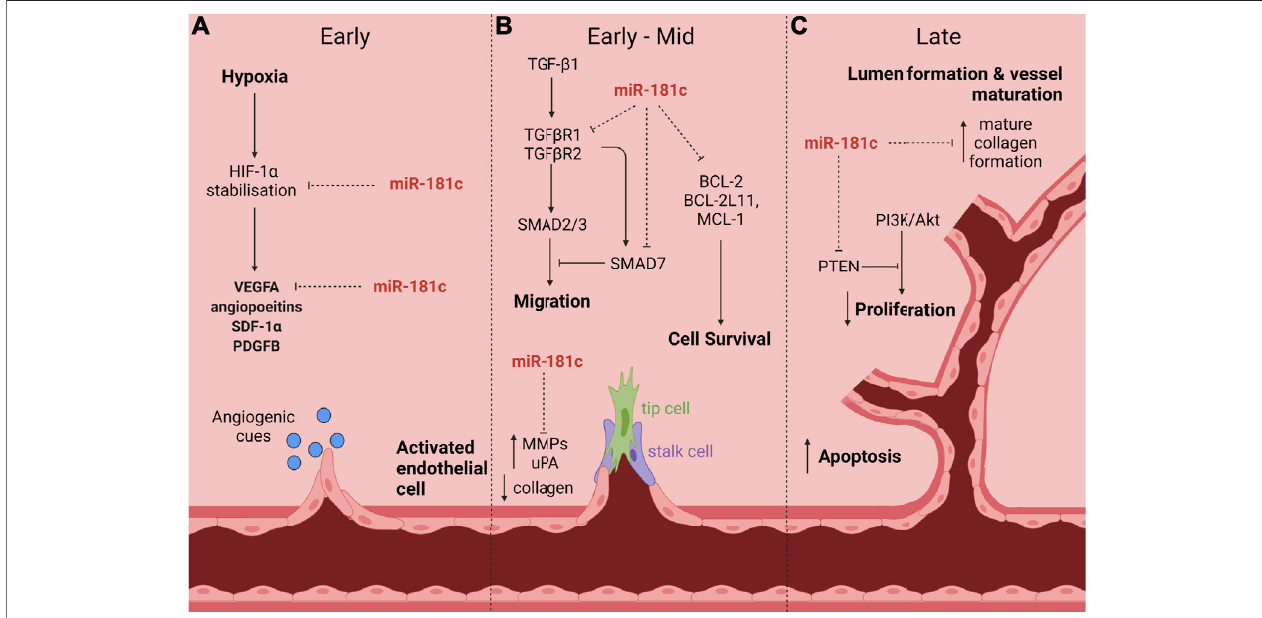
FIGURE 2 | The proposed role of miR-181c action in diabetes-impaired angiogenic responses to ischaemia. Numerous studies have shown that miR-181c targets many signaling pathways and cellular processes that are critical in diabetes-impaired angiogenic responses to ischaemia. This includes (A) HIF-1 α stabilisation and VEGFA expression in the early phase; (B) TGF- β signaling (via TGF β R1, TGF β R2 and SMAD7) to inhibit cell migration, BCL-2 and its family members BCL-2L11 and MCL-1 which drive cell survival and MMPs and uPA in the early-mid phase; and (C) PTEN and dysregulation of collagen in the late phase. Created with